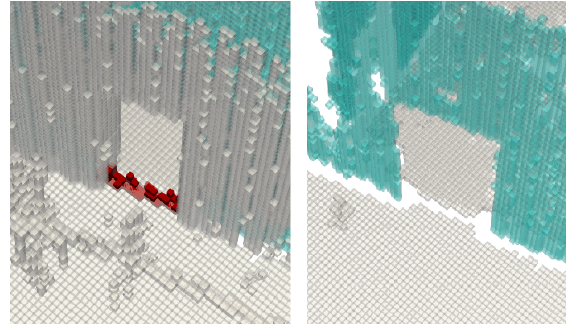
Figure 8. Left: Voxels (in red) of the original point cloud that lie on the floor inside a doorway, right: voxels inside door frame removed, creating a